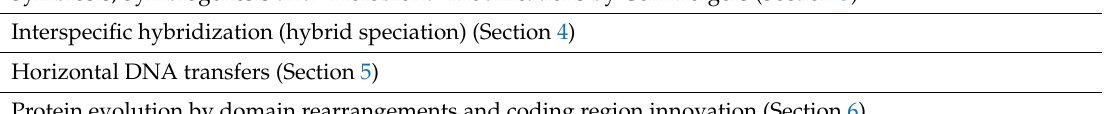
Table 2. Selected Variation Processes that Lead Repeatedly and Abruptly to Adaptive and Taxonomic Novelties. Symbiosis, Symbiogenesis and “Holobiont” Modifications by Cell Mergers (Section 3) Interspecific hybridization (hybrid speciation) (Section 4) Horizontal DNA transfers (Section 5) Protein evolution by domain rearrangements and coding region innovation (Section 6) Mobile DNA activity to restructure genomes, rewire developmental regulatory networks and form regulatory long non-coding RNA molecules (Section